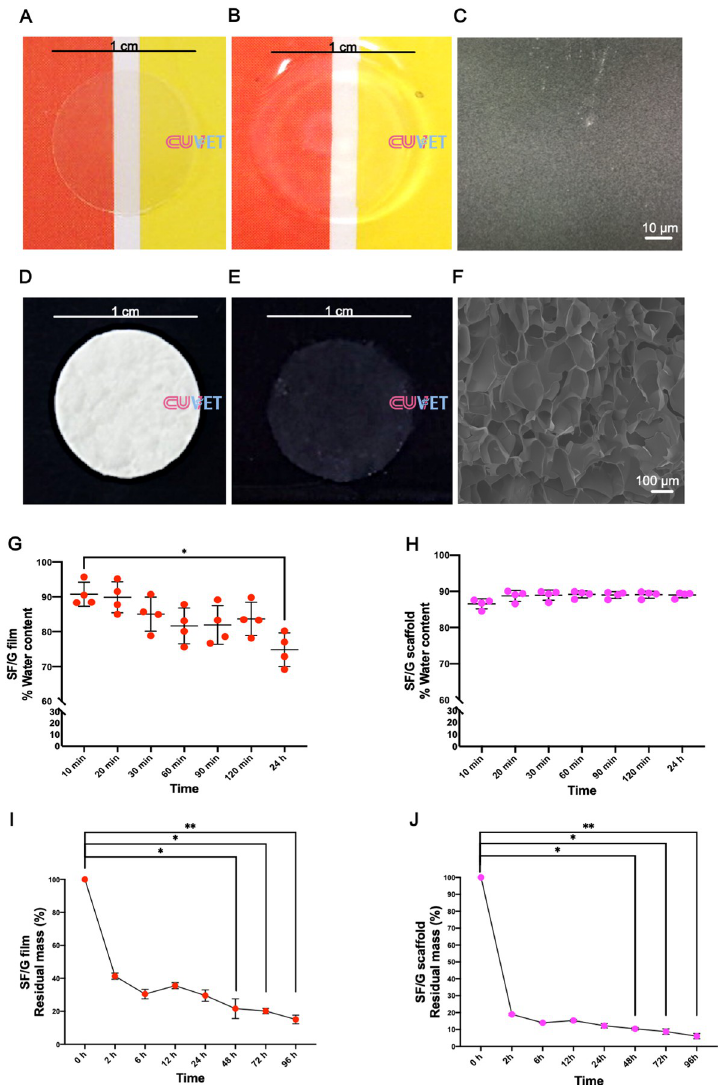
ultrastructure features, scanning electron microscope shows a smooth surface for the SF/G corneal film (1000x magnification) (C). A 100x magnification view of SF/G stromal scaffold shows a porous surface (F). Equilibrium of water content related to swelling capacity of SF/G corneal film (G) and SF/G stromal scaffold (H) are presented. Enzymatic in vitro degradation rate of SF/G corneal film (I) and SF/G stromal scaffold (J) using protease XIV solution are also presented. Data are from 4 independent experiments (n = 4) ± standard deviation ( � p < 0.05, �� p < 0.01). The scale bars present 1 cm (A, B, D, E), 10 μ m (C) and 100 μ m